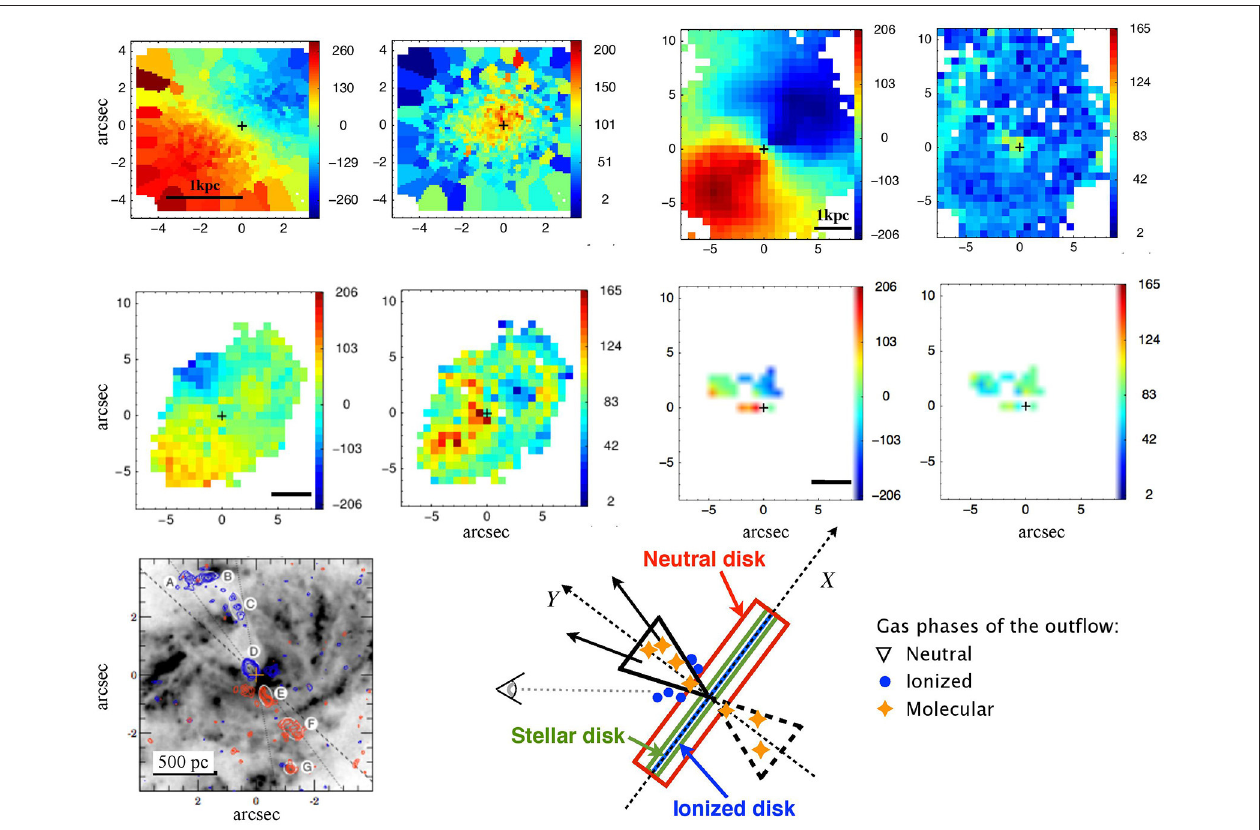
FIGURE 1 | Spectral maps and HST image of IRAS F11506-3851. Top-left: SINFONI/VLT velocity and velocity dispersion maps of stars (CO absorption bands). Top-right: the same maps but for the ionized gas (H α narrow component) obtained using VIMOS/VLT cubes. Middle: velocity and velocity dispersion maps of neutral gas (left) and ionized gas (right) obtained analyzing the NaD absorption and the H α broad component in VIMOS/VLT data. All these maps, from Cazzoli et al. (2014), are in km/s units. The cross marks the galaxy nucleus. Bottom-left: A zoomed-in view of the optical morphology (ACS/HST F814W-image) in gray scale with red and blue contours indicating the redshifted and blueshifted, respectively, molecular outflowing clumps detected by ALMA. The dashed lines indicate the minor axis and dotted lines the opening angle. The figure is adapted from Pereira-Santaella et al. (2016). Bottom-right: toy model of the outflows and disks summarizing our results, adapted from Cazzoli et al. (2014). Credit: Cazzoli, A & A, 569, A14, 2014, and PereiraSantaella2016, A & A, 594, A81, 2016, reproduced with permission ©